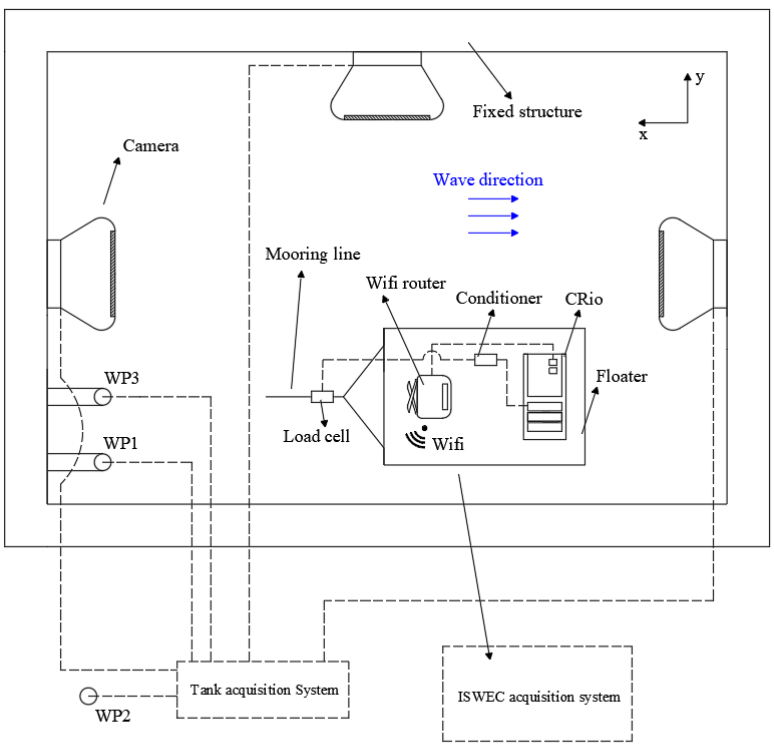
Figure 8. ISWEC prototype and wave tank acquisition